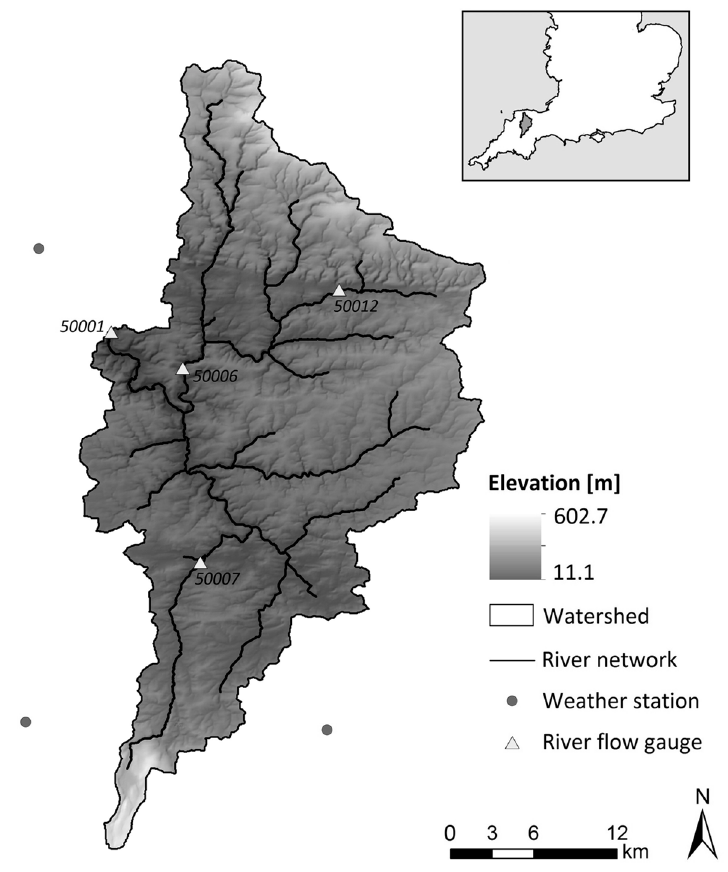
Figure 1. Digital Elevation Model (DEM) of the Taw at Umberleigh river basin and location of weather stations and river flow gauges.